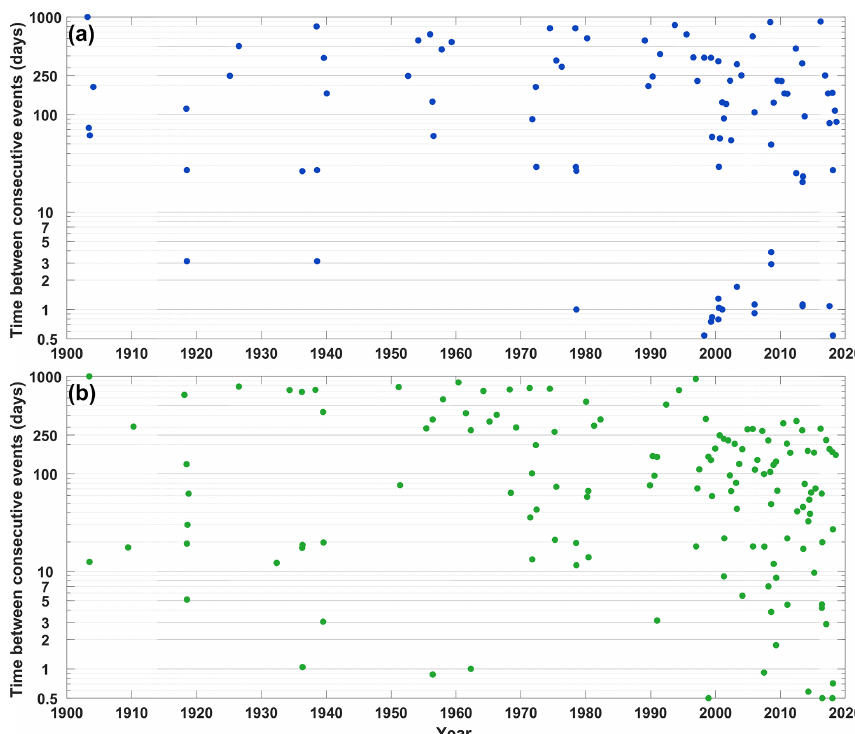
Figure 8. Time between successive events: (a) storm tide and (b) skew surge.